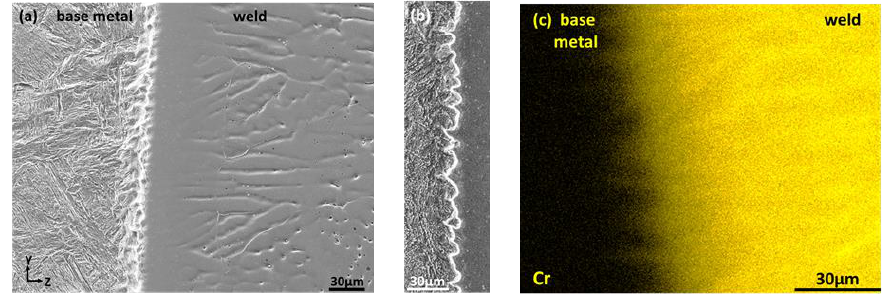
Figure 3. Microstructure near the fusion line. ( a ) SEM micrograph after electro-nitric etching showing the transition between plane front and cellular growth modes; ( b ) SEM micrograph of the fusion boundary after light electro-nitric etching; ( c ) EDS map for chromium.